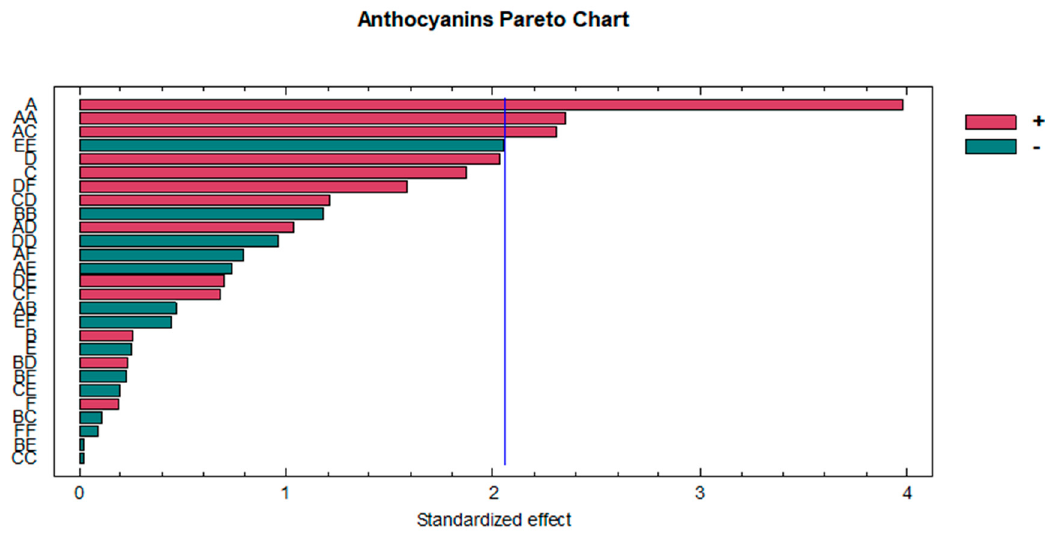
Figure 2. Standardized Pareto chart representing the extraction optimization of total anthocyanins. A: solvent (% MeOH); B: temperature (°C); C: amplitude (%); D: cycle (s); E: pH; F: ratio (mL).